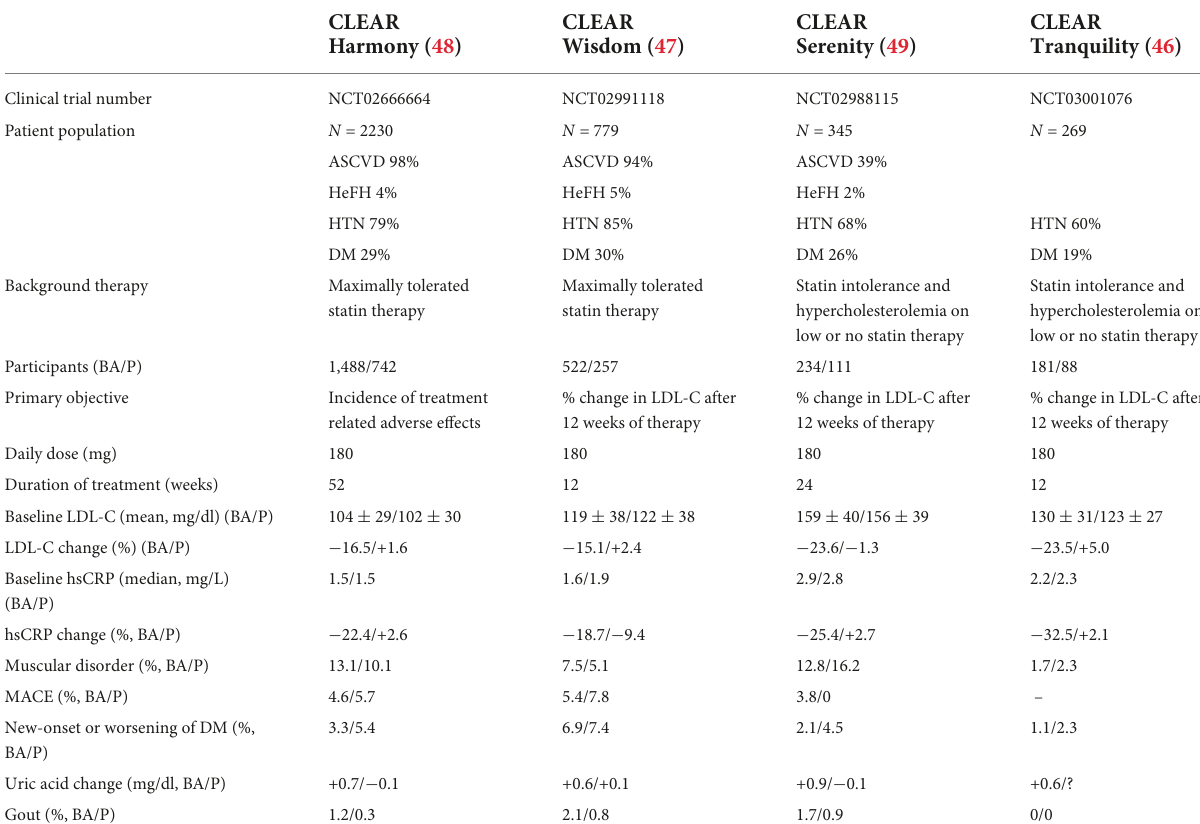
TABLE 2 Phase 3 clinical trials of bempedoic